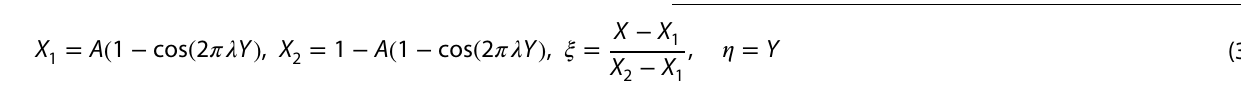
= 1 , H * = 10 , R = 0 . 5 , ε = 0 . 5 , γ = 0 . 5 , Φ = π/ 3 , λ = , α = , ϕ c d